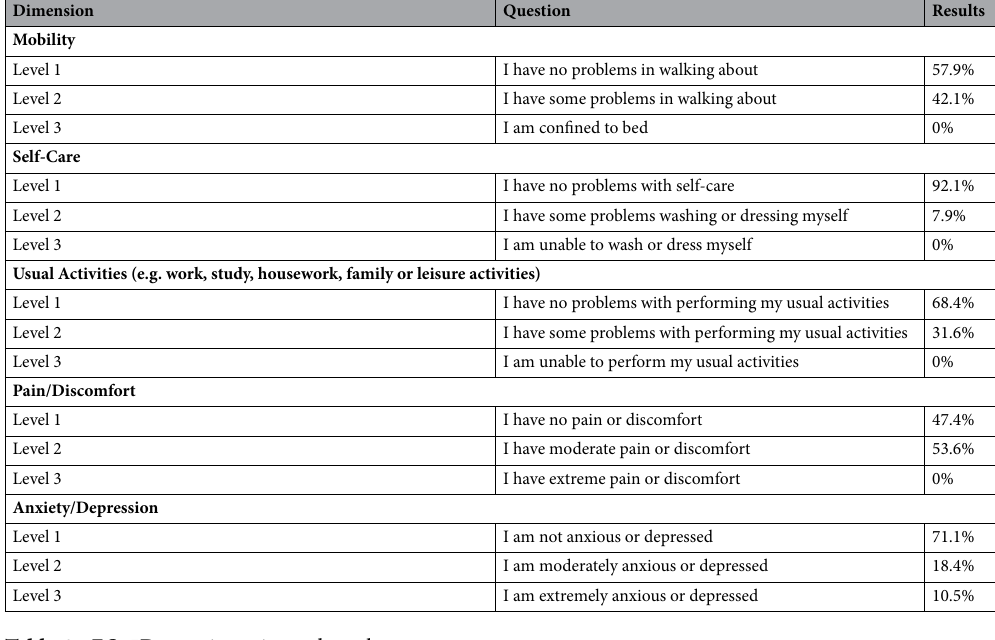
Table 4. EQ-5D questionnaire and results.